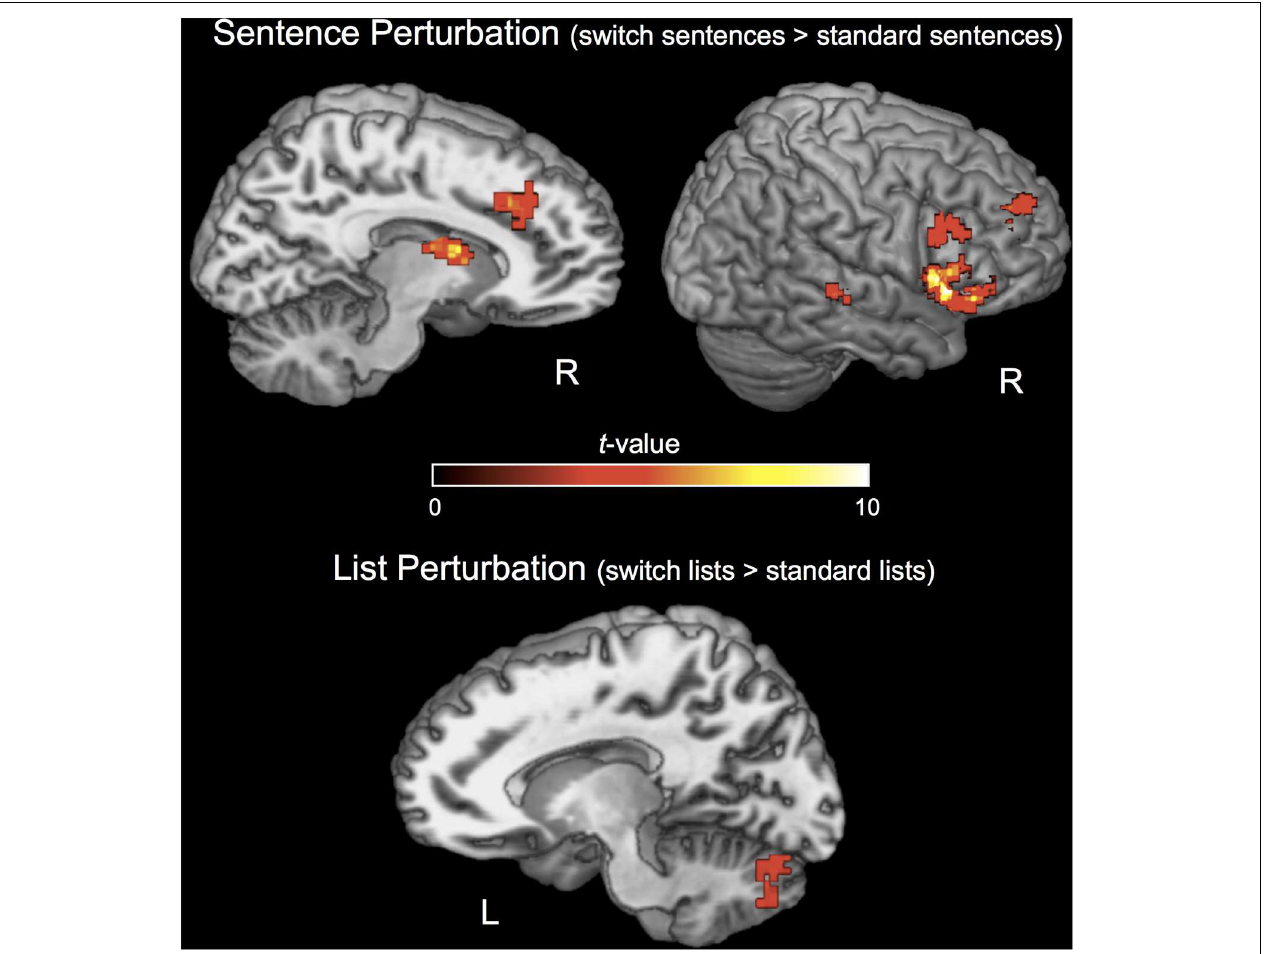
FIGURE 5 | Activations for the PERTURBATION contrasts. N = 20. Activations are displayed on a Talairach template brain and cluster-corrected for multiple comparisons at FWE p < 0.05, individual voxel threshold p < 0.001 (one-tailed), cluster size threshold 610 mm 3